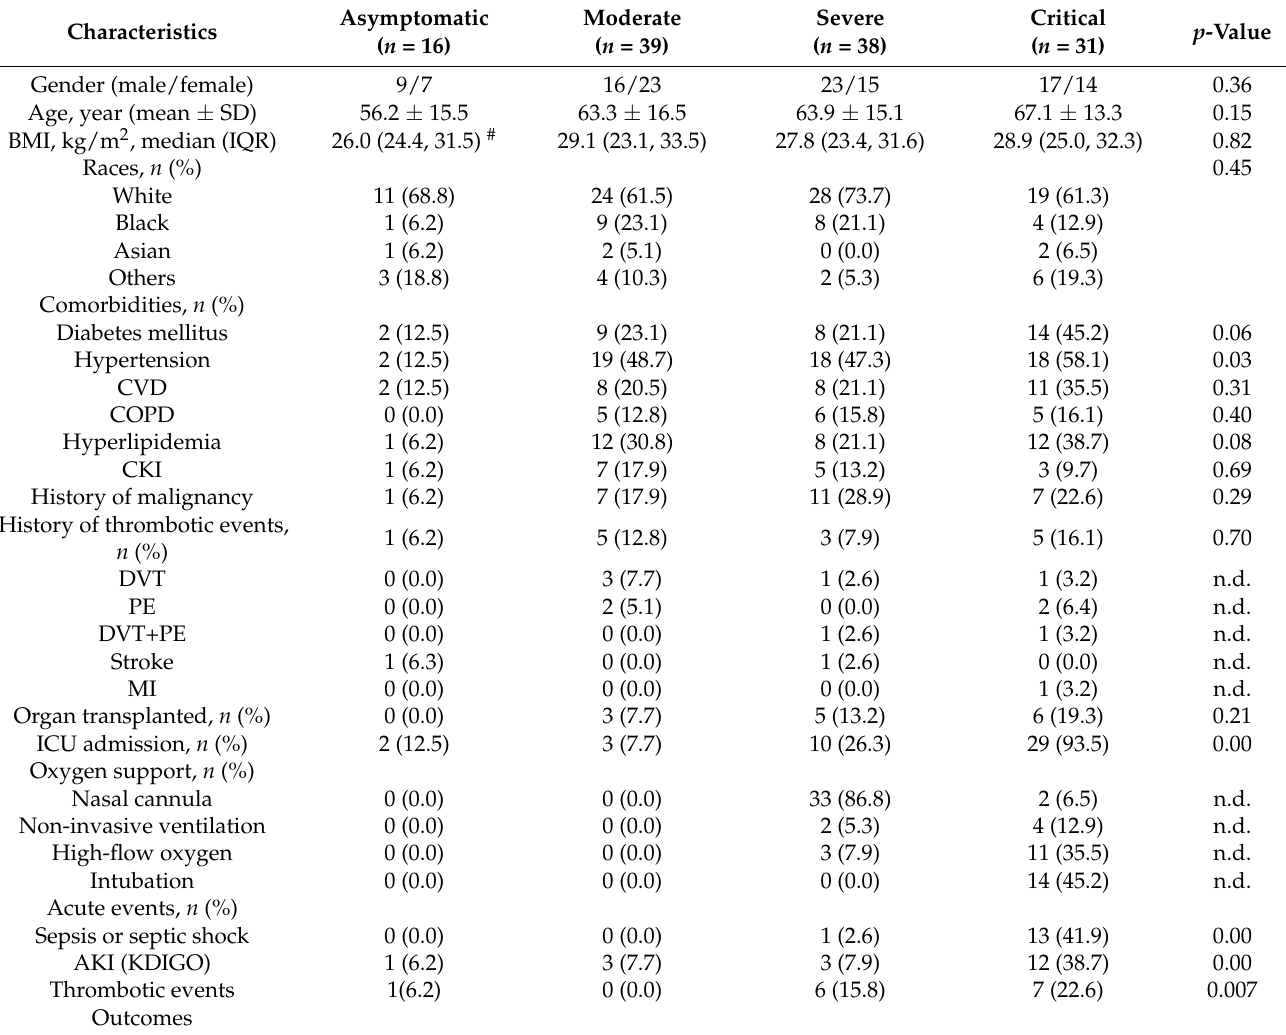
Table 1. Demographics and clinical characteristics in 124 patients with SARS-CoV-2